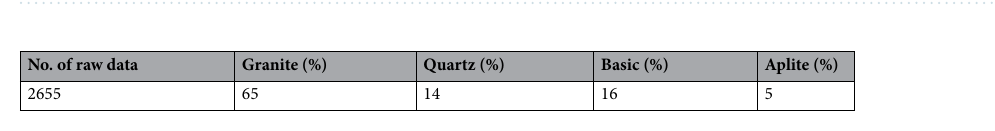
Figure 3. ( a ) Drill hole layout of the deposit, ( b ) down the hole drill hole traces, ( c ) vertical projection of drill holes over a cross-section along AA ′ . The colour map indicates the different lithotypes.